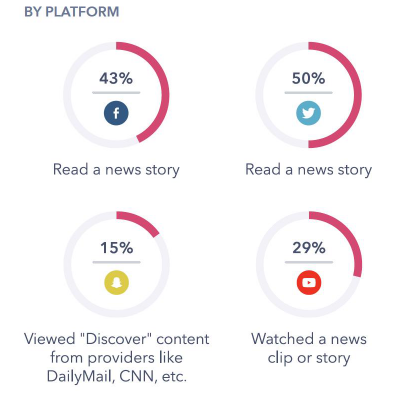
Figure 2. Reads. Source: Report 2018. Global Web Index. Report in social